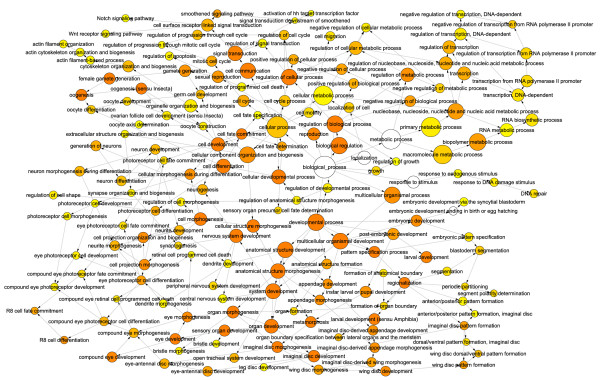
dFmr1 BiNGO. Directed acyclic graph of over-represented GO-terms in the highest scoring dFmr1 active sub-network. Node size indicates the number of genes associated with each GO-term (i.e. larger nodes represent GO-terms associated with many genes in the active sub-network). Node color indicates significance of over-representation based on Benjamini-Hochberg corrected p-value: white = p > .0001, yellow = p < .0001, red = p << .0001.